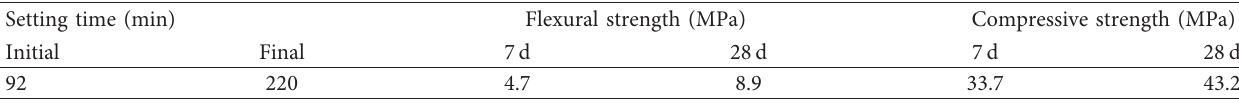
Table 4: Physical properties of the cement.